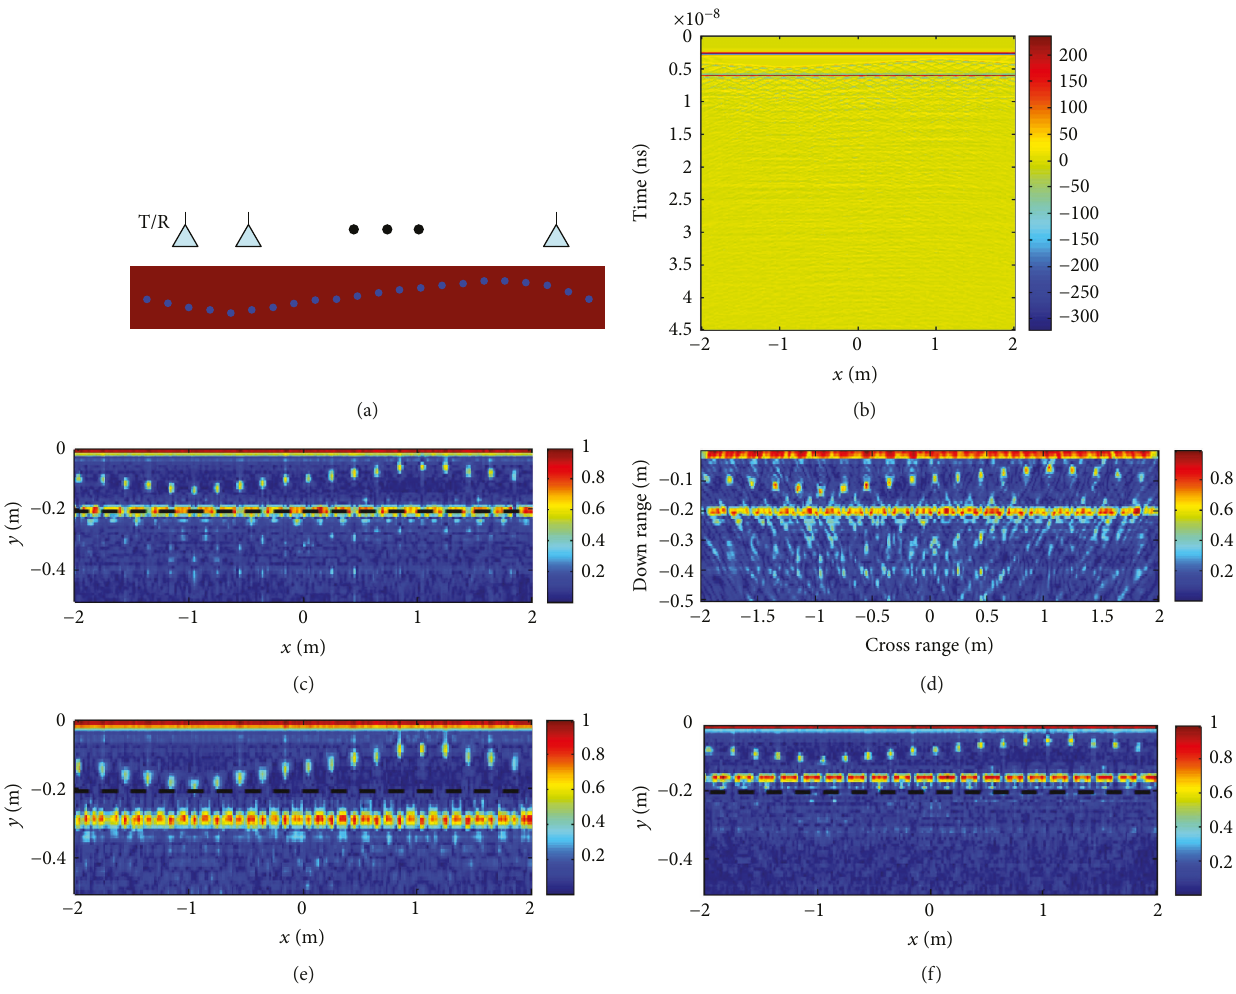
Figure 2: Imaging of a reinforced wall. (a) Geometrical distribution of the steel bars inside the wall. (b) Time domain raw data. (c) Imaging result using the proposed algorithm, correct wall parameter, ε =6. (d) Imaging result using the ray tracing-based back-projection algorithm, b correct wall parameter, ε =6. (e) Imaging result using the proposed algorithm, underestimated wall parameter, ε b the proposed algorithm, overestimated wall parameter, ε b